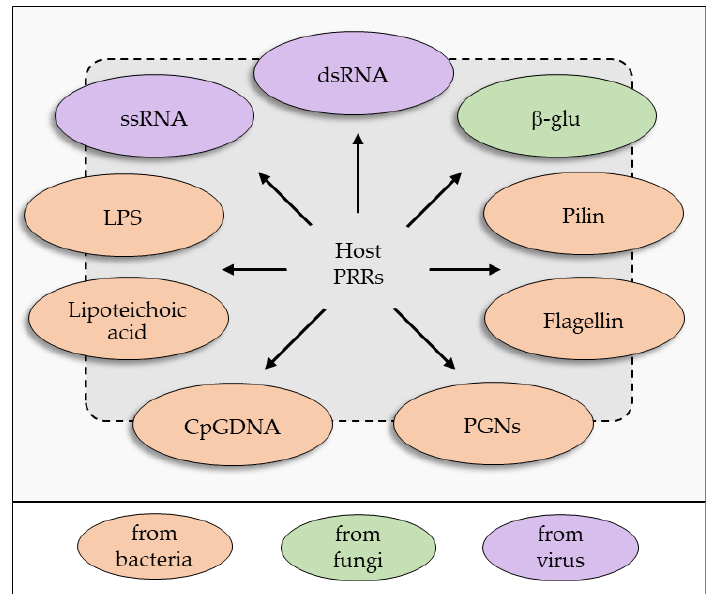
Figure 3. PAMPs from invaders are recognized by free, or cell-associated host receptors (PRRs). Typical PAMPs are: bacterial lipopolysaccharide (LPS), bacterial peptidoglycans (PGNs), β -glucans from fungi ( β -glu), lipoteichoic acid from Gram positive bacteria, bacterial flagellin and pilin, nucleic acid variants such as single or double-stranded RNA (ssRNA, dsRNA) and unmethylated CpG motifs (CpGDNA).